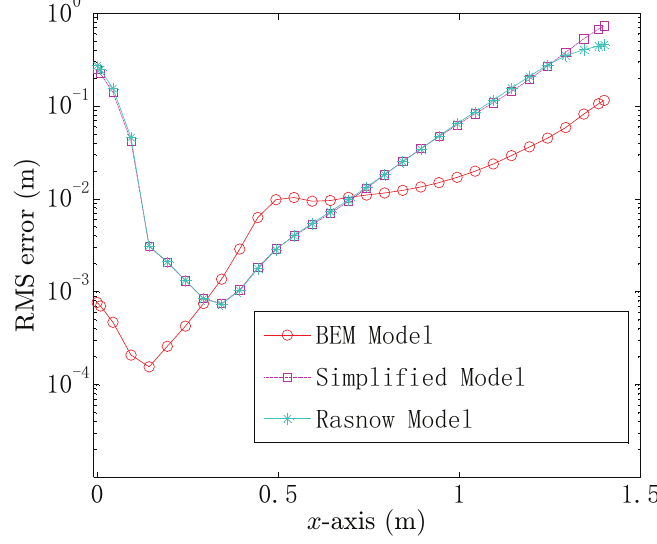
Figure 6. The locating RMS errors by using the boundary element method (BEM) model, the simplified model and the Rasnow